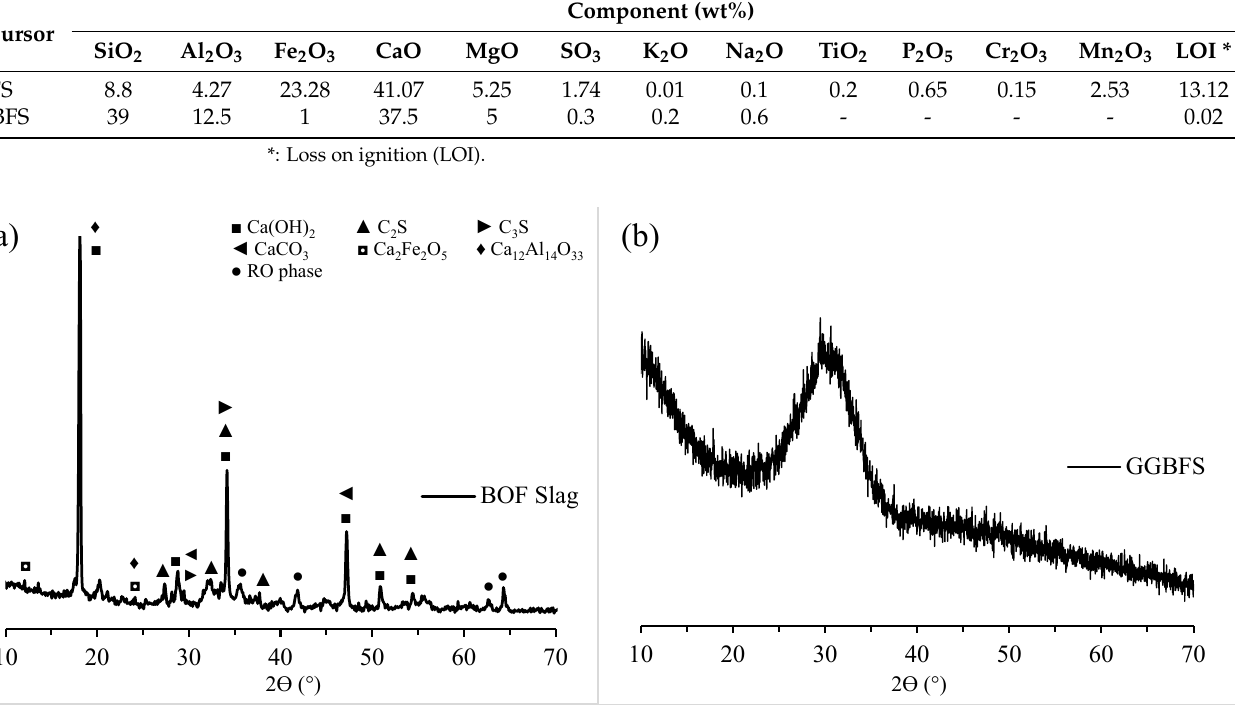
Figure 2. SEM photographs of ( a ) BOFS and ( b ) GGBFS. Table 1. Oxide compositions of BOFS and GGBFS.